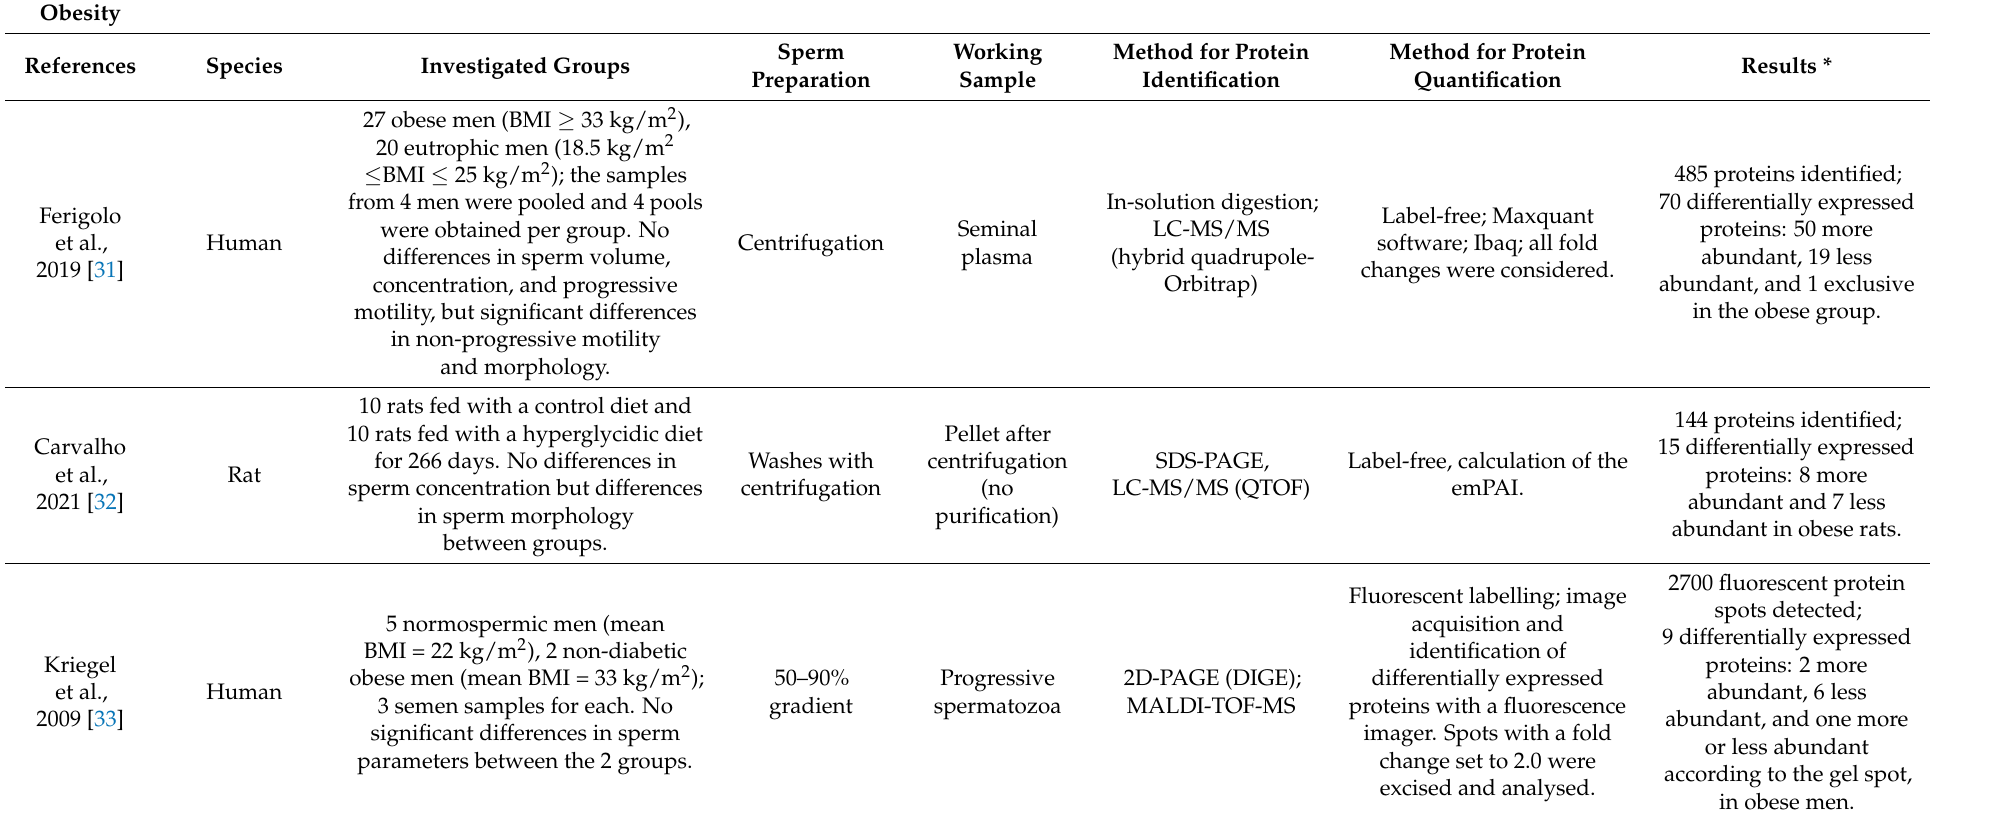
Table 1. Studies using global proteomic analyses to identify sperm deregulated proteins in relation to male infertility risk